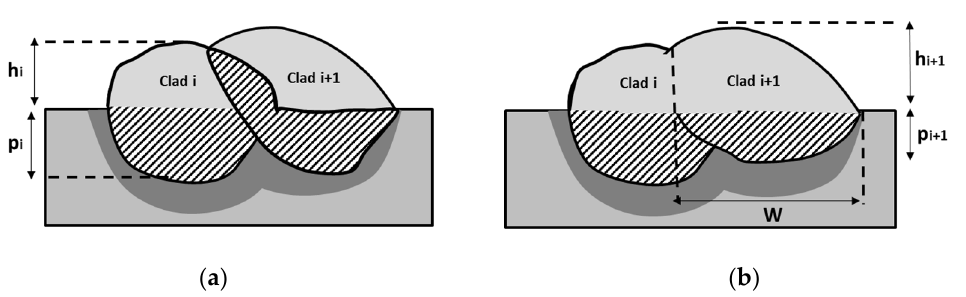
Figure 4. Scheme of the dilution of the adjacent clad i + 1. ( a ) Real; ( b ) model.